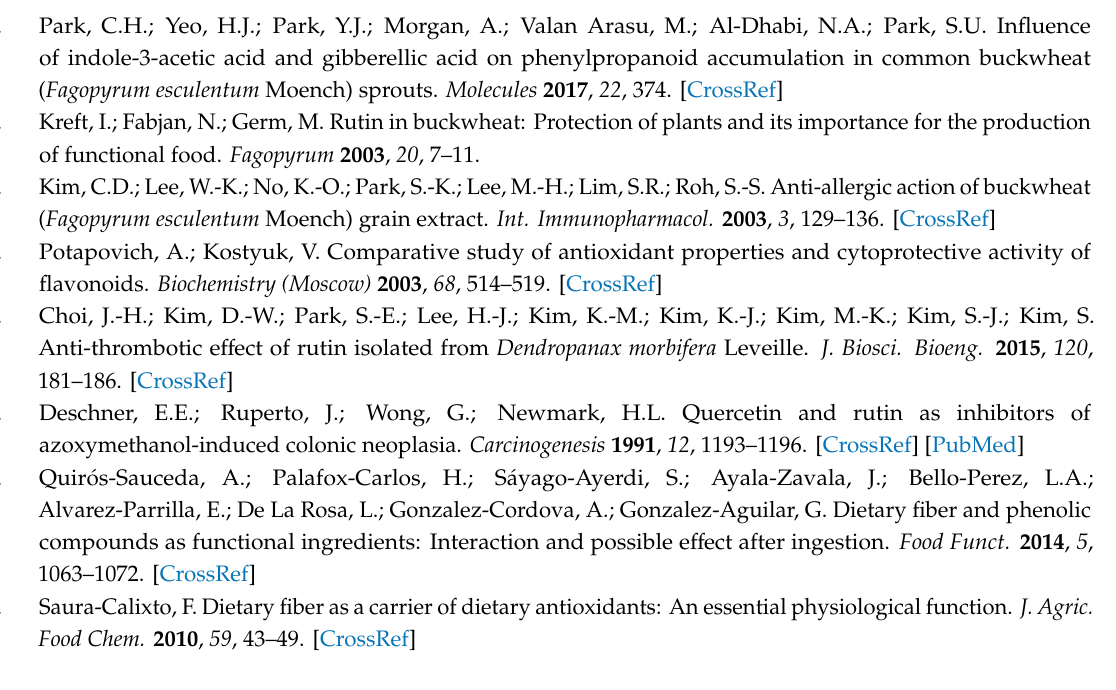
Figure S1: Chemical structures of the phenolic compounds and benzoic acid, Table S1: The e ff ect of 0.1% chitosan and 150 µ M jasmonic acid on the growth of germinated buckwheats grown for 72 h. Author Contributions: S.Y.L. and S.U.P. designed the experiments and analyzed the data. C.H.P., H.J.Y., Y.E.P., S.W.C., and Y.S.C. performed the experiments and analyzed the data. C.H.P. and H.J.Y. wrote the manuscript. All authors read and approved the final